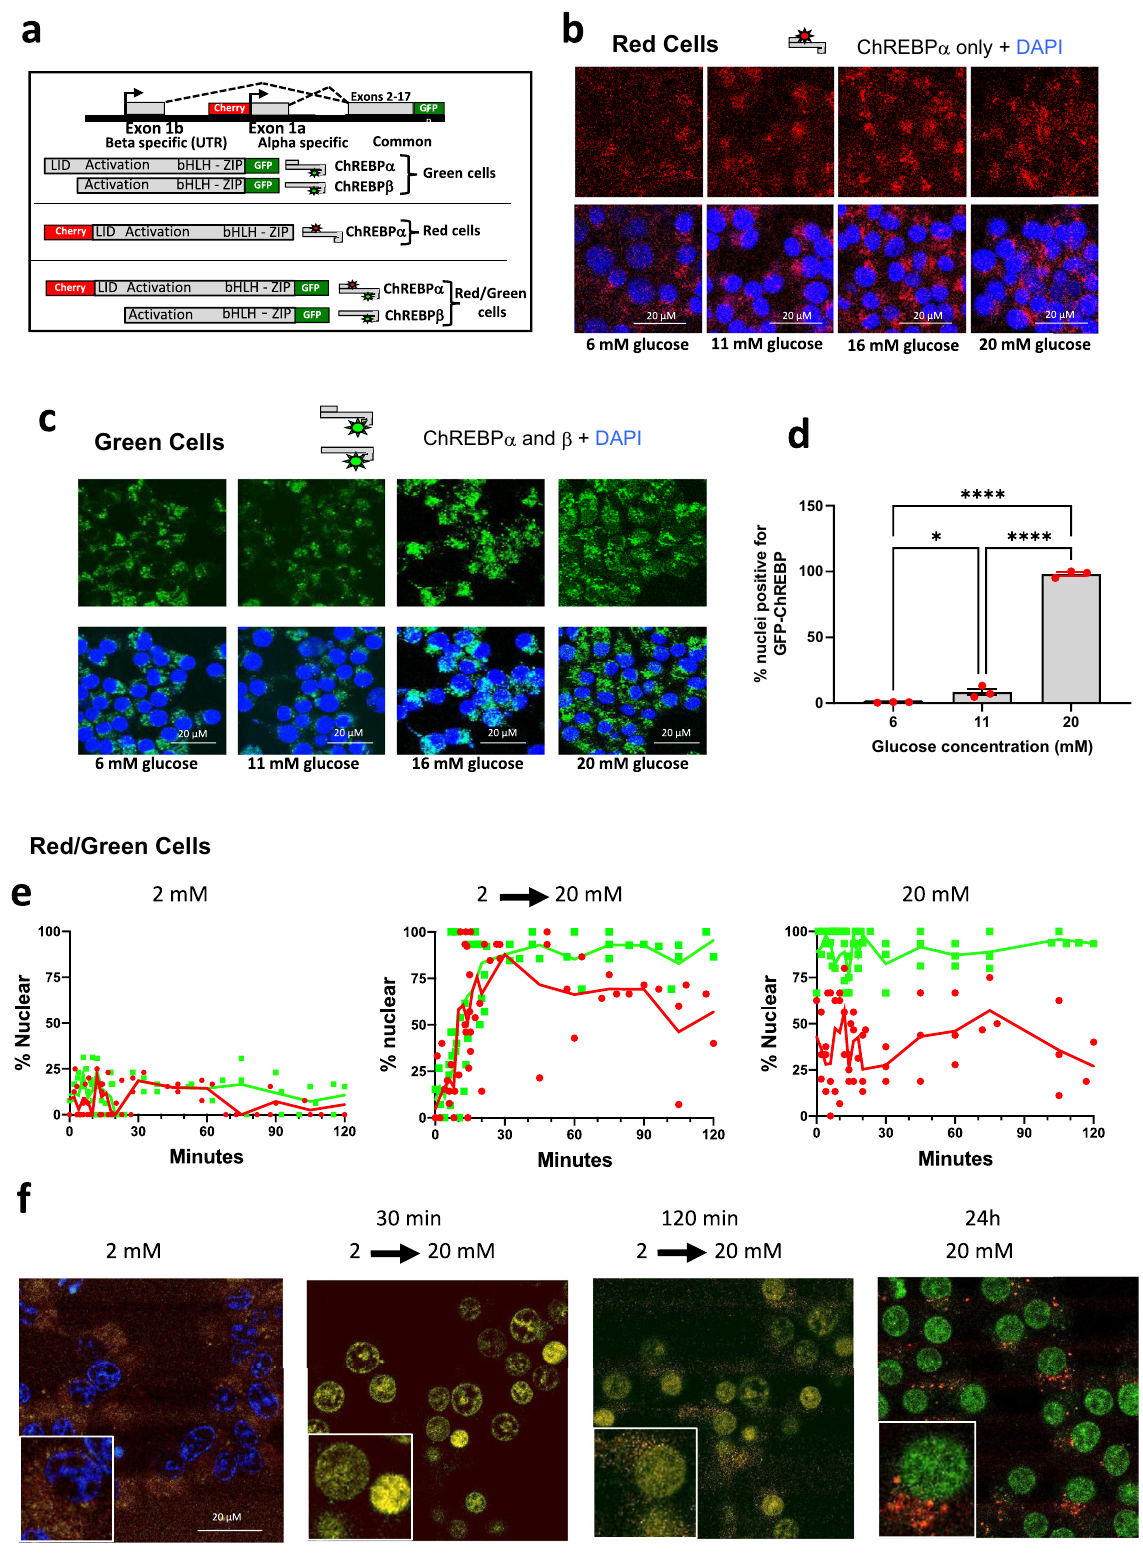
Fig. 2 | Cellular localizationofgenetically editedand taggedChREBP isoforms in response to glucose. a Design of labeled ChREBP isoforms. mCherry and eGFP were integrated into the genome using the CRISPR/Cas9 method for gene editing inframewithexon1aandexon17.b, c ConfocalliveimagingwasperformedonRed or Green INS-1 cells after incubation with the indicated concentrations of glucose for72h. d Thepercentnucleargreen fl uorescencefrom c wasdetermined.Dataare the means ± SEM, n =3, * P <0.05; **** p <0.0001 using one-way ANOVA. e , f Red/